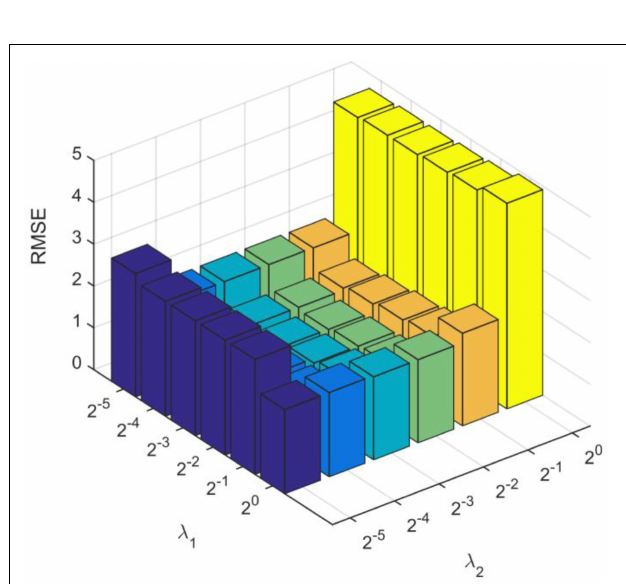
FIGURE 4 | Root mean square errors under different regularization